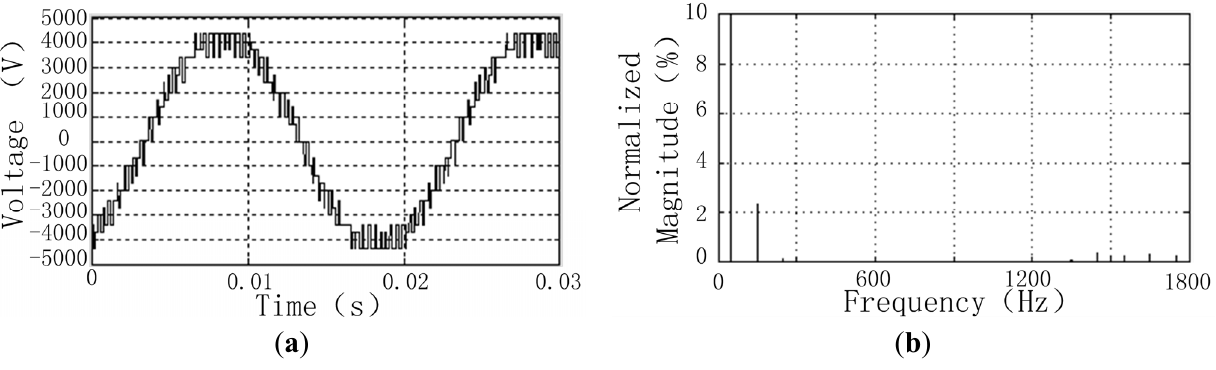
Figure 7. Result of the proposed PSCPWM when the second cell dc voltage is 690 V: ( a ) output voltage waveform; and ( b )